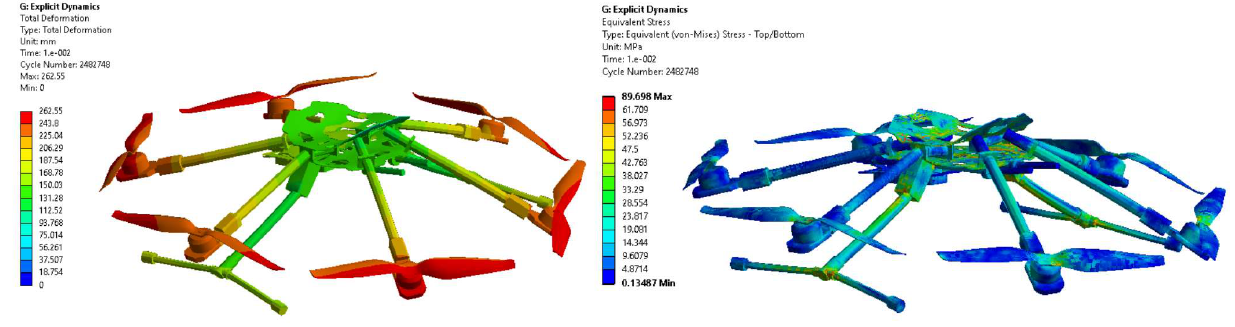
Figure 43. Drop test results at 0.1s after the impact.